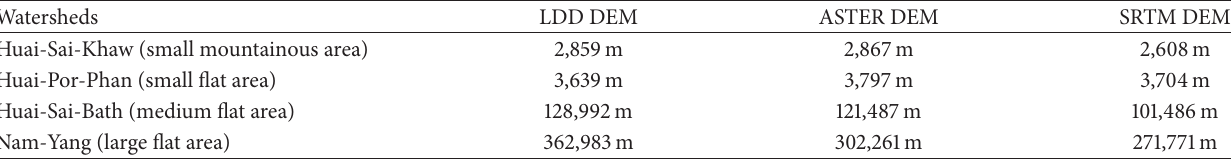
Table 10: Stream lengths extracted from LDD DEM, ASTER DEM, and SRTM DEM.